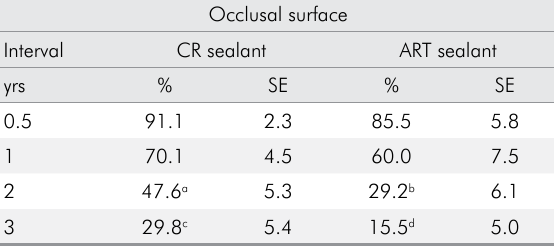
Table 4. Cumulative survival rates (%) and standard errors (SE) of fully and partially retained sealants calculated according to the modified criterion in occlusal surfaces over a period of 3